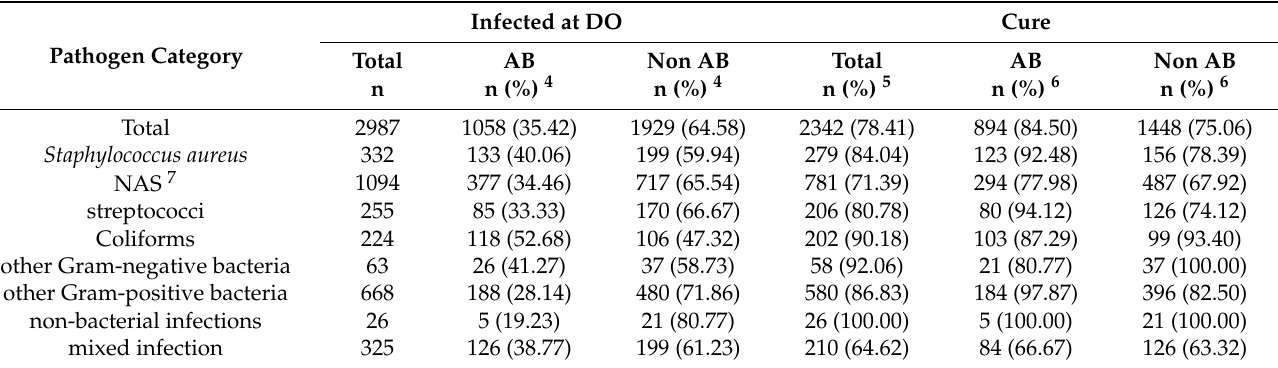
Table 2. Number of quarters infected at DO 1 and cured during the dry period in each DCT 2 group (AB 3 and non-AB) for all pathogen categories.